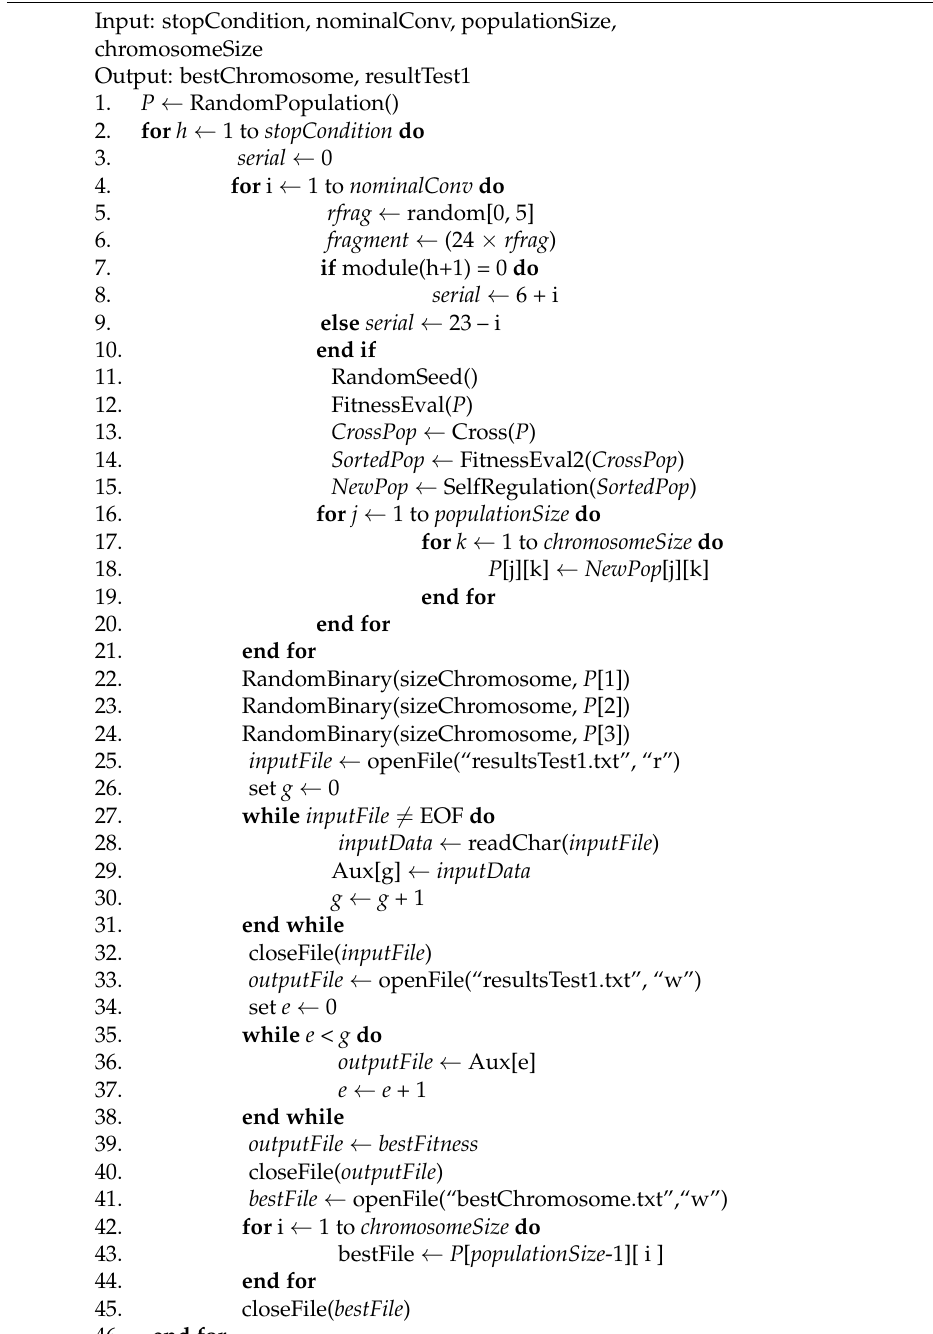
Algorithm 3 Main